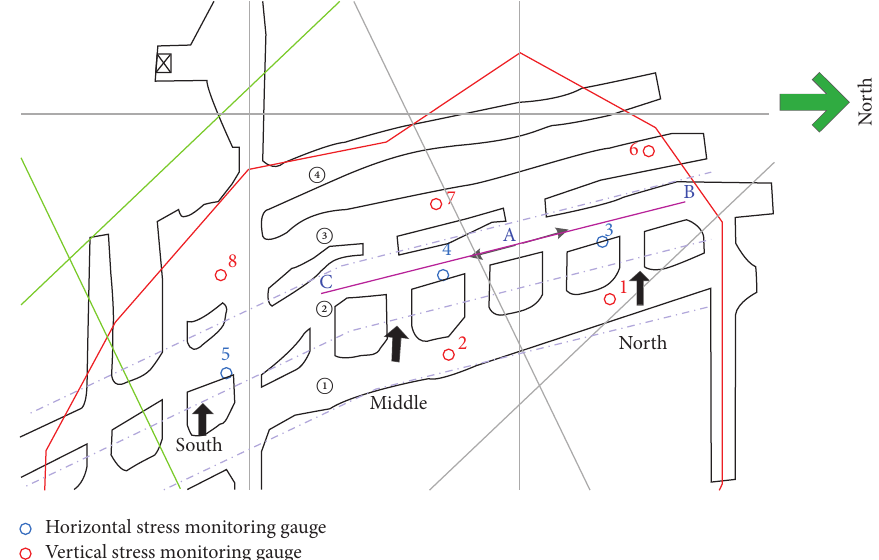
Figure 10: Layout of pressure relief holes and stress monitoring